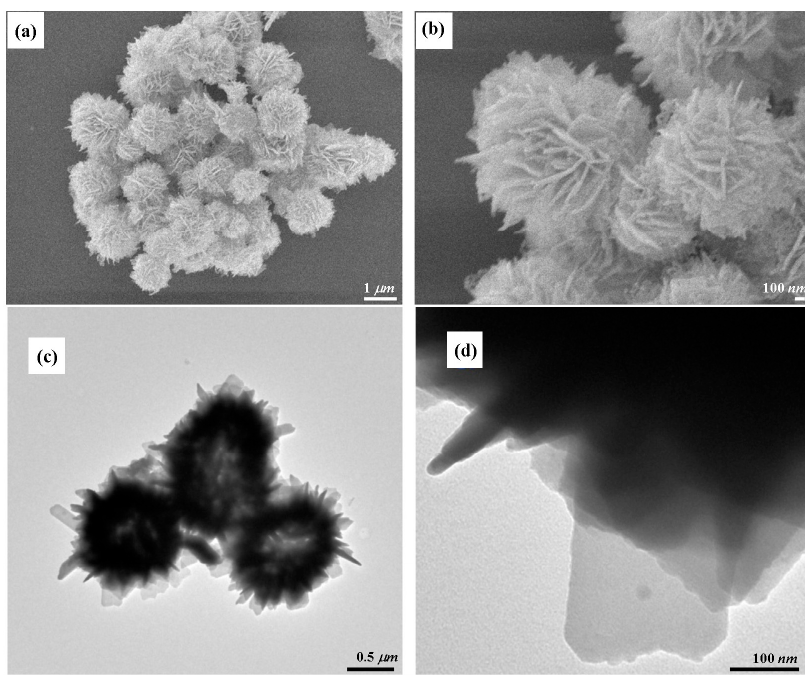
Figure 2. SEM ( a , b ) and TEM ( c , d ) images of Fe 2 O 3 /PANI nanocomposite particles. (Tian et al. [98], Copyright Elsevier,